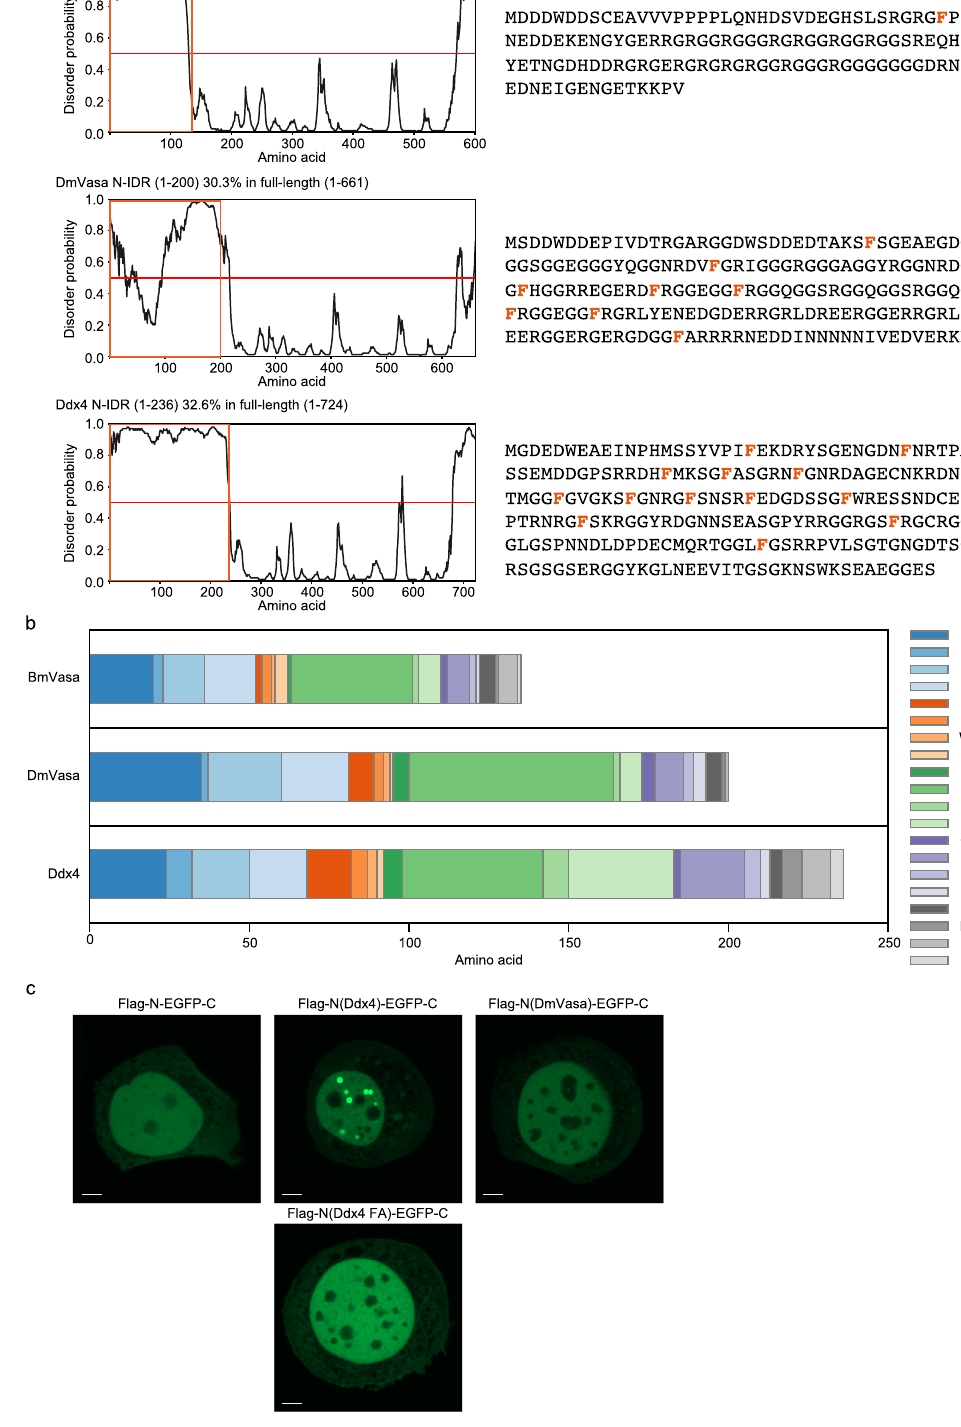
Fig. 4 | Peptide composition of N-IDR affects the assembly of nuage-like structures. a Disorder probability of BmVasa, DmVasa (N-terminal region of DmVasa corresponding to N-IDR of BmVasa), and Ddx4 33 (left). Orange open box and red line on the disorder plots represent N-IDR and disorder probability=0.5, respectively. Peptide sequences of N-IDR of BmVasa, DmVasa and Ddx4 are also shown (right). Phenylalanine is indicated in orange. b Amino acid composition of N-IDR of BmVasa, DmVasa and Ddx4. c N-terminus of Flag-BmVasa N-EGFP-C was